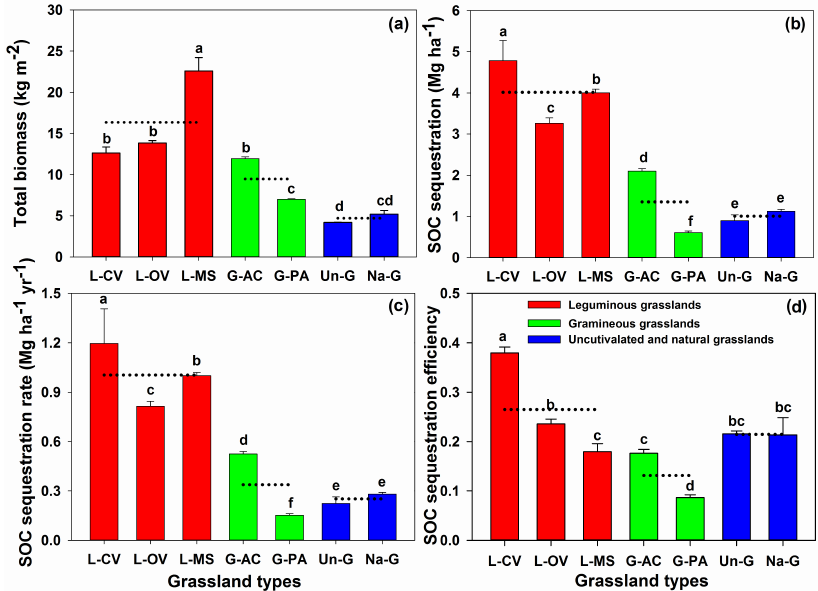
Figure 2. Total biomass (a) , SOC sequestration (b) , SOC sequestration rate (c) , and SOC sequestration efficiency (d) for different grasslands from 2008 to 2012. The grassland types are L-CV, Coronilla varia ; L-OV, Onobrychis viciifolia ; L-MS, Medicago sativa ; G-PA, Poa praten- sis ; G-AC, Agropyron cristatum ; Un-G, uncultivated grassland; Na-G, natural grassland. Bars indicate mean ± standard error. Bars with the different lowercase letters above them indicate there was significant difference between the means at p <0.05 level. The dotted lines indicate the means of the same grassland types. Table 3. Two-way ANOVA F and p values for the effects of plot types, year, and interactions on total biomass (TB), soil organic carbon content (SOC), soil C storage, and soil bulk density (BD). TB SOC C storage